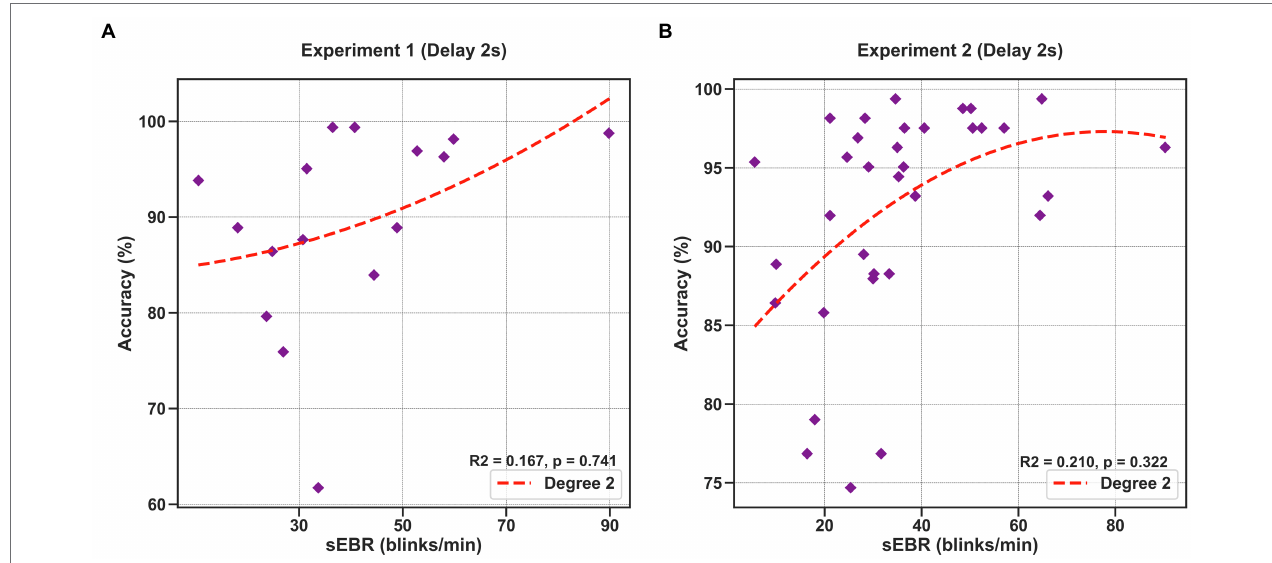
FIGURE 8 | Polynomial regression model between task accuracy and sEBR during the first 2 s of the delay for Experiment 1 and Experiment 2. Regression plots show sEBR during the first 2 s of the Delay on the x-axis and task accuracy on the y-axis. (A) Polynomial regression model fitted on sEBR during the Delay and task accuracy in Experiment 1. (B) Polynomial regression model fitted on sEBR during the Delay and task accuracy in Experiment 2. Fitted red line represents polynomial regression model fit. The relationship between sEBR and WM performance appears to be non-linear and explains about 20% of the variance in Experiment 2 but does not reach significance.